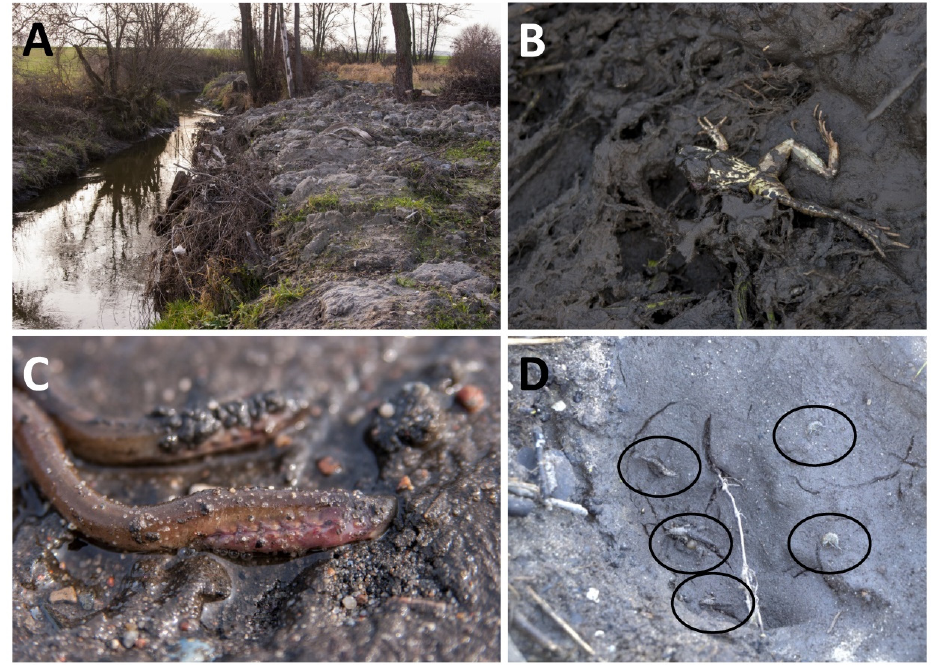
Figure 4. Environmental consequences of dredging agricultural rivers: ( A ) modified hydromorphology of the Czaplinianka River; ( B ) dead amphibians found in the excavated material ( Ś lina River); ( C ) dead Ukrainian brook lampreys Eudontomyzon mariae ( Ś lina River); ( D ) dead macroinvertebrates ( Gammaridae and Ephemeroptera ). Photos: courtesy of Pawe ł